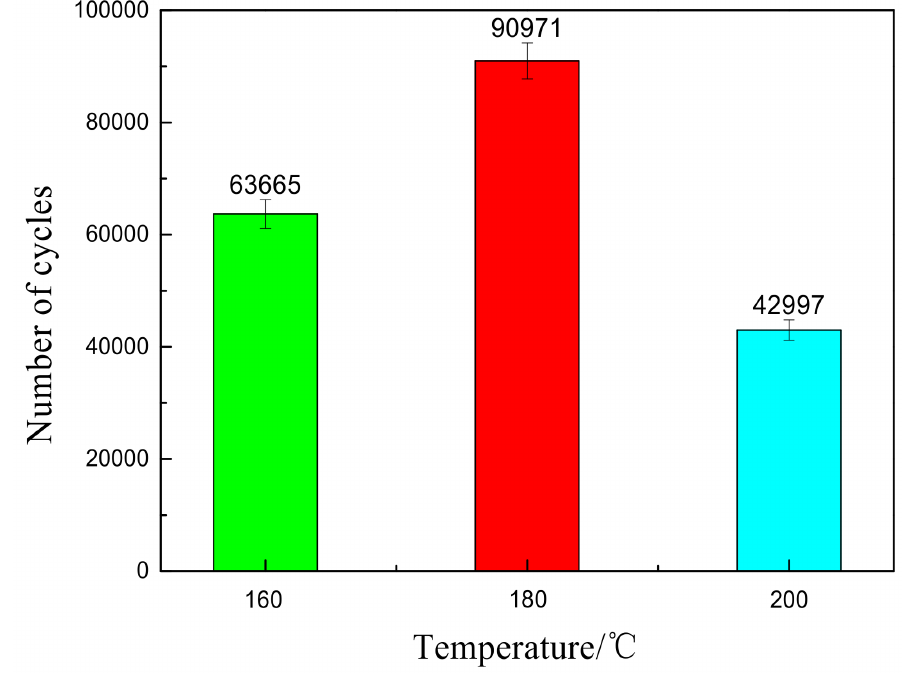
Figure 4. The fatigue life of the alloy under a constant stress of 180 MPa after 12 h of creep aging at different aging